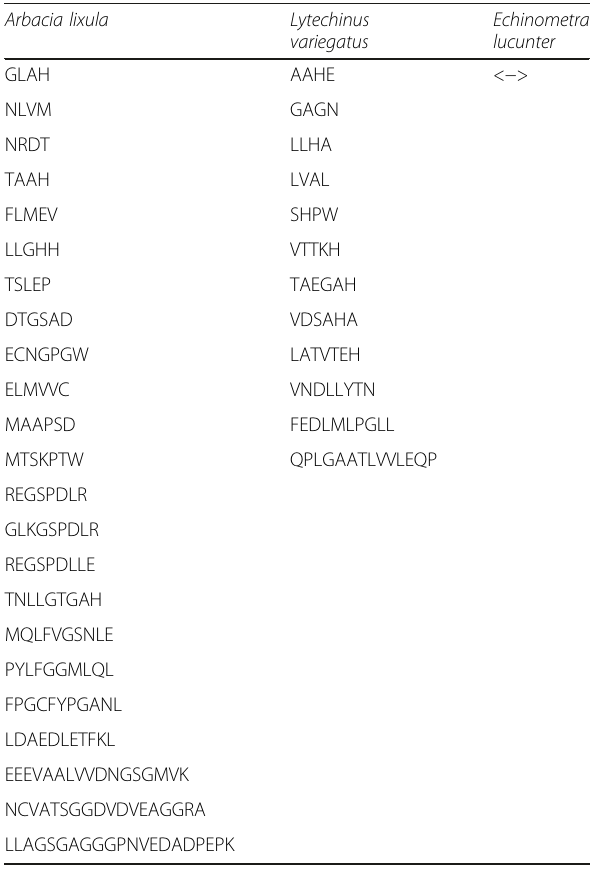
Table 2 Peptides identified and de novo sequenced in the spines of sea